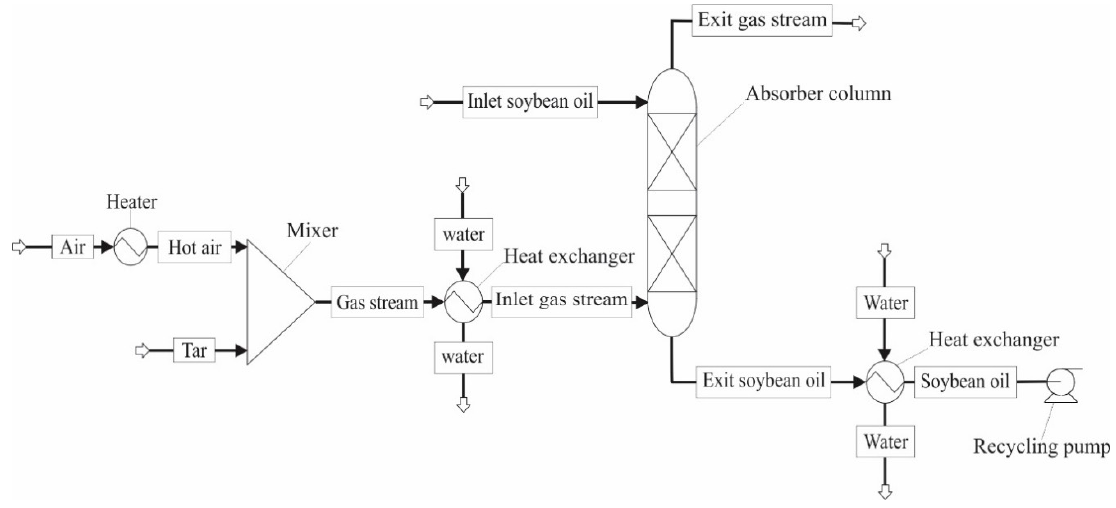
Figure 6. Flowsheet of process simulation in ASPEN PLUS.